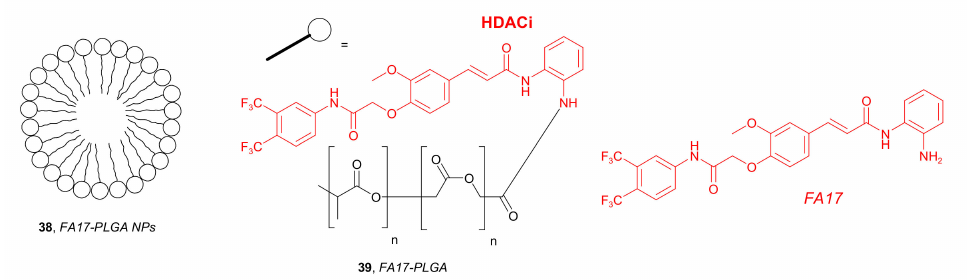
Figure 19. Chemical structures of FA17-PLGA NPs 38 , FA17-PLGA 39 , and FA17 . In 2017, Thapa et al. used a water-insoluble zein plant protein polymer to prepare SAHA and Bortezomib 40 (proteasomal inhibitor, Figure 20) combination-loaded zein NPs for the treatment of metastatic prostate cancers [68]. The obtained NPs were characterized by pH-dependent drug release profiles and exhibited high uptake in different prostate cancer cells. Importantly, treatment with zein NPs containing SAHA and Bortezomib demonstrated synergistic enhancement in anticancer efficacy in all prostate cancer cell lines examined (PC3, DU145, and LNCaP). Furthermore, an improved anti-migration effect and the ability to induce the pro-apoptotic proteins in the cells were also observed. Their anticancer properties were tested in a PC3 tumor xenograft mouse model, showing minimal toxicity and an antitumor effect greater than that observed for each free active agent.